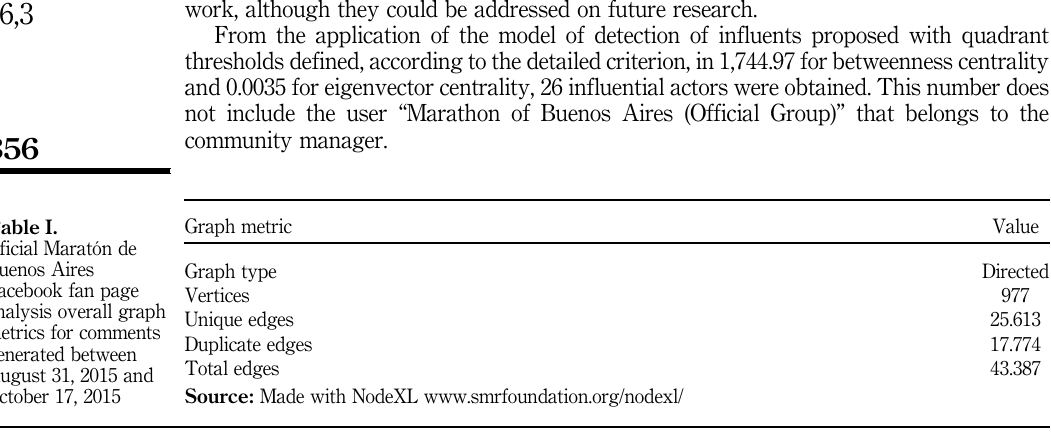
Figure 4. Distribution of